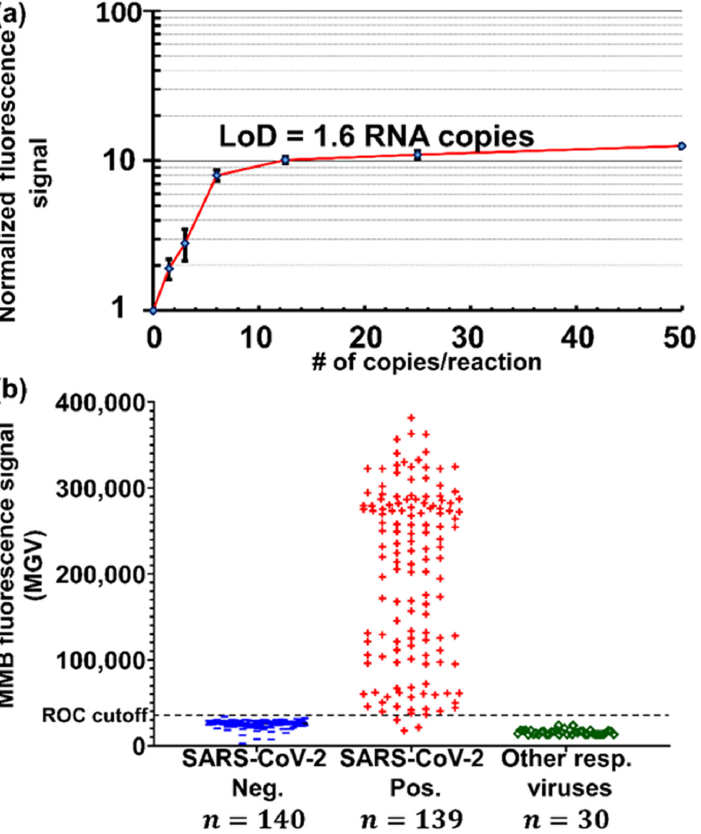
Figure 13. ( a ) Analytical performance of the MMB-based SARS-CoV-2 molecular assay. ( b ) Clinical performance of the MMB-based SARS-CoV-2 molecular assay. Reprinted (modified) from [60], Copy- right (2021) with permission from Elsevier.